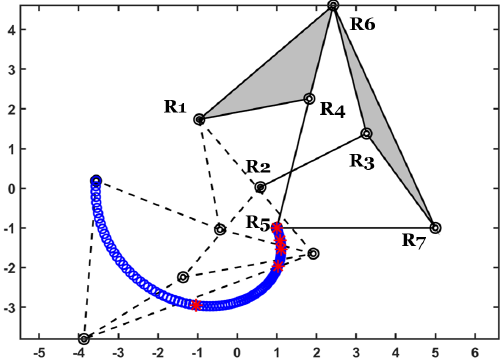
Figure 6. The trajectory of the designed linkage mechanism.